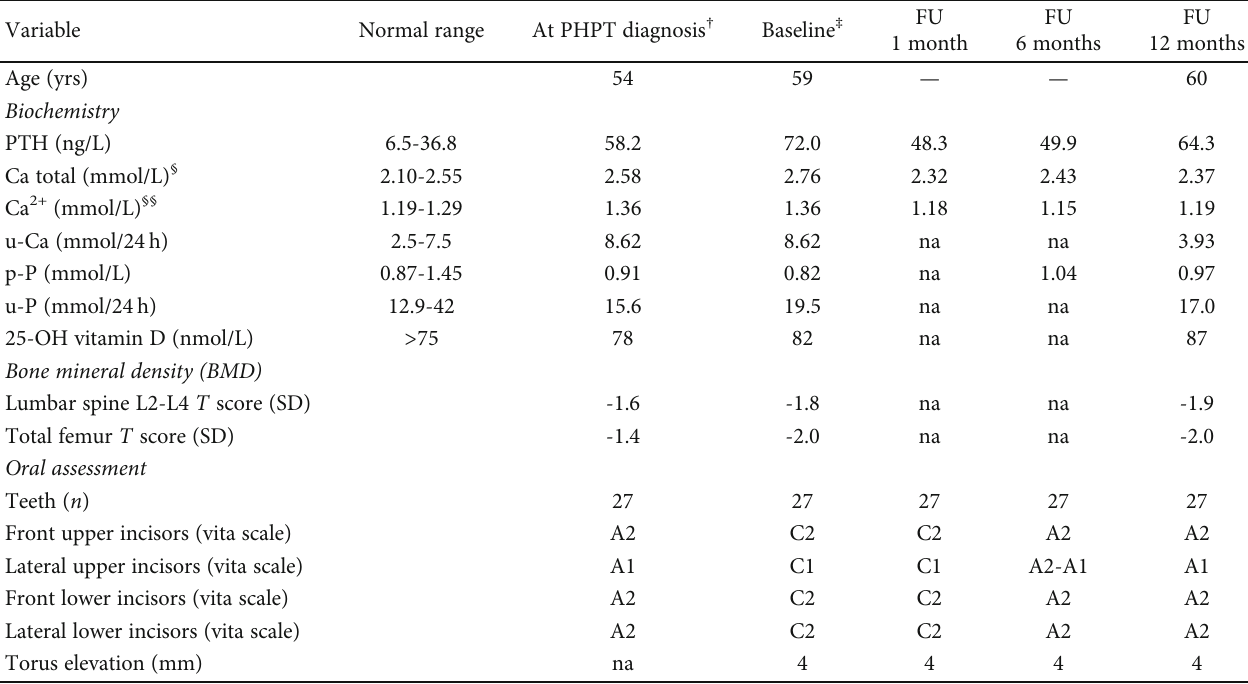
Table 1: Patient ’ s characteristics at baseline and